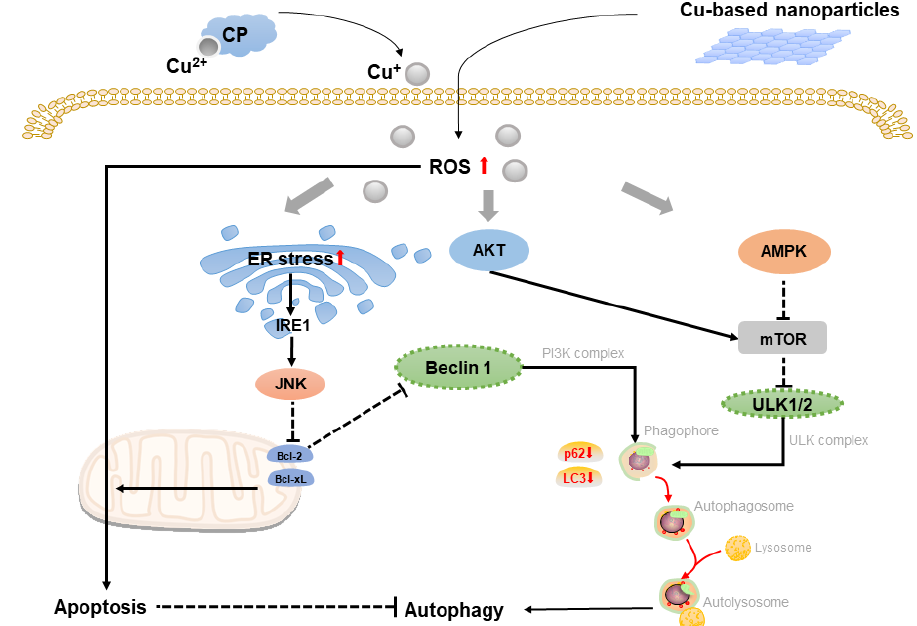
Figure 2. Schematic representation of copper-based autophagy. Cu-induced OS and ROS could activate both AMPK and AKT signaling pathways, and activated AMPK downregulated mTOR pathway. However, activated AKT promoted mTOR signaling. After then, inhibited mTOR could block the deregulation of ULK1/2 that could enhance the autophagy process. Increased ROS also activated IRE1 pathway via ER stress, which could increase the expression of Beclin 1 by activating JNK signaling pathway via downregulated Bcl family that promoted autophagy. Elevated Cu-induced ROS also increased apoptosis that resulted in inhibition of autophagy.